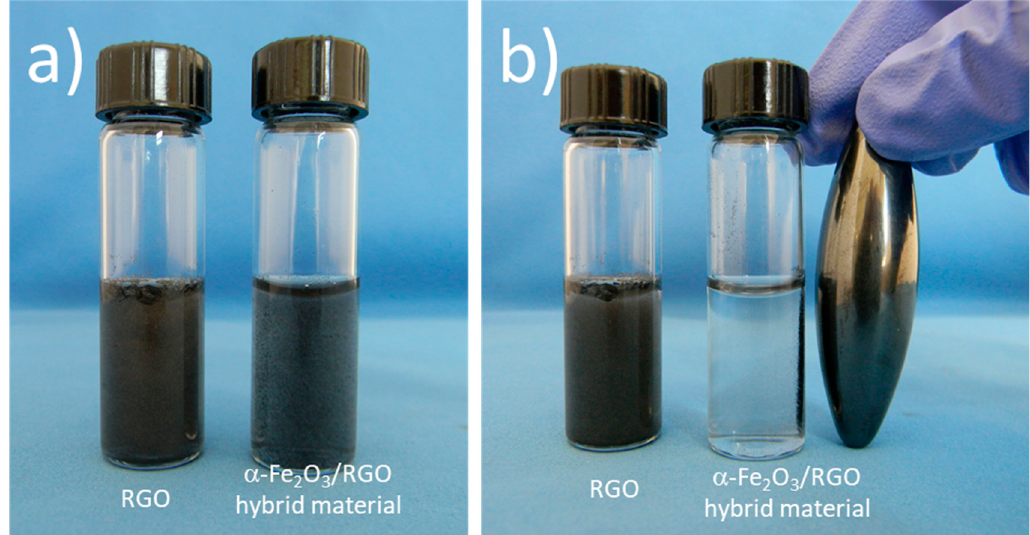
Figure 7. Pictures of RGO and α -Fe 2 O 3 /RGO hybrid material dispersion in pH 4 buffer solution ( a ) before and ( b ) after exposing a magnetic field.